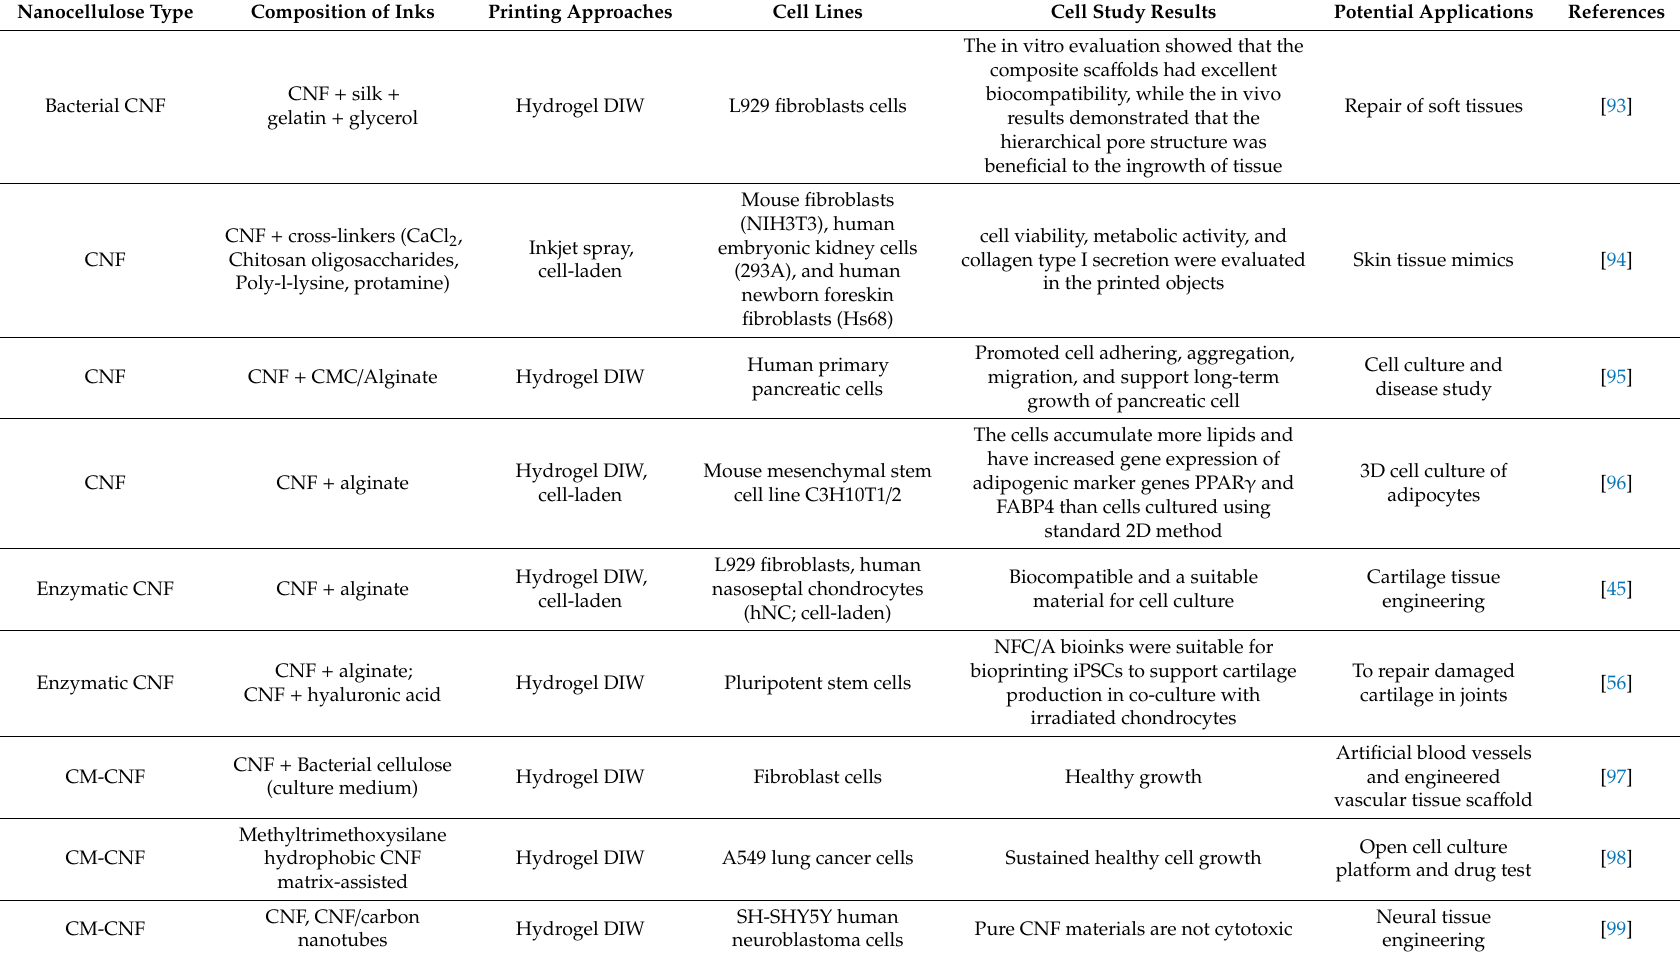
Table 1. Overview of recently developed nanocellulose-incorporated ink formulations and their in-vitro cell culture